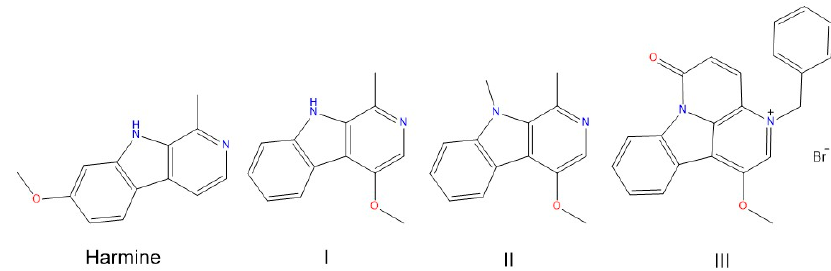
Figure 1. Chemical structure of harmine (7-methoxy-1-methyl-9 H -pyrido(3,4-b)indole), and its synthetic derivatives: I (4-methoxy-1-methyl-9H-pyrido(3,4-b)indole), II (4-methoxy-1,9-dimethyl-9 H -pyrido (3,4- b )indole), and III (3-benzyl-1-methoxy-6-oxo-6 H -indole[3,2,1-de]-[1,5]-naphthyridinin-3-ium bromide).